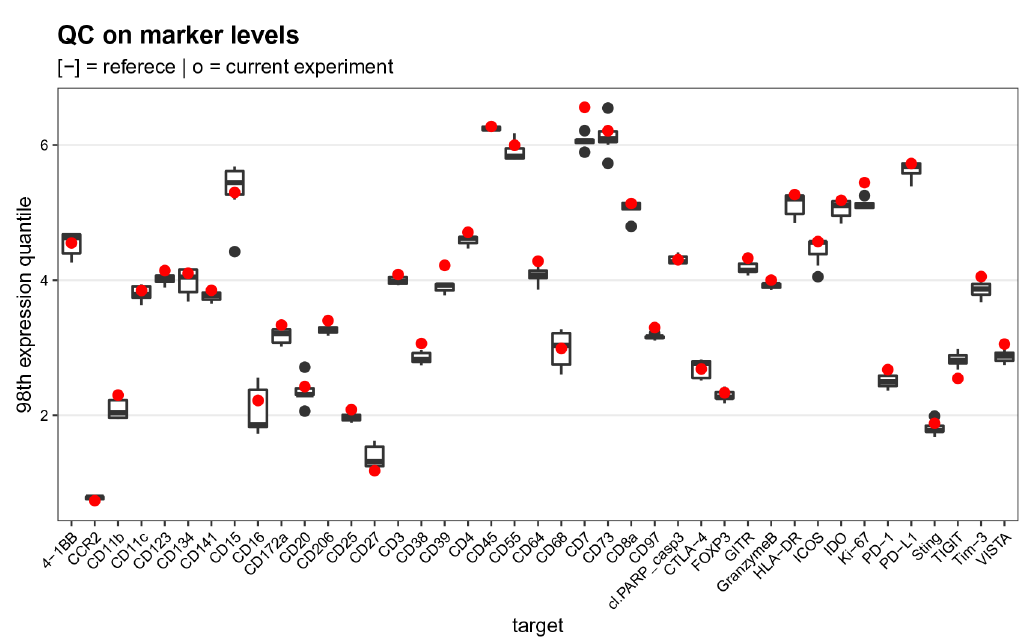
Figure 16. Mean marker expression quality control. Boxplot comparing the mean marker expression obtained for the current experiment (shown in red) to those from 7 previously acquired experiments.